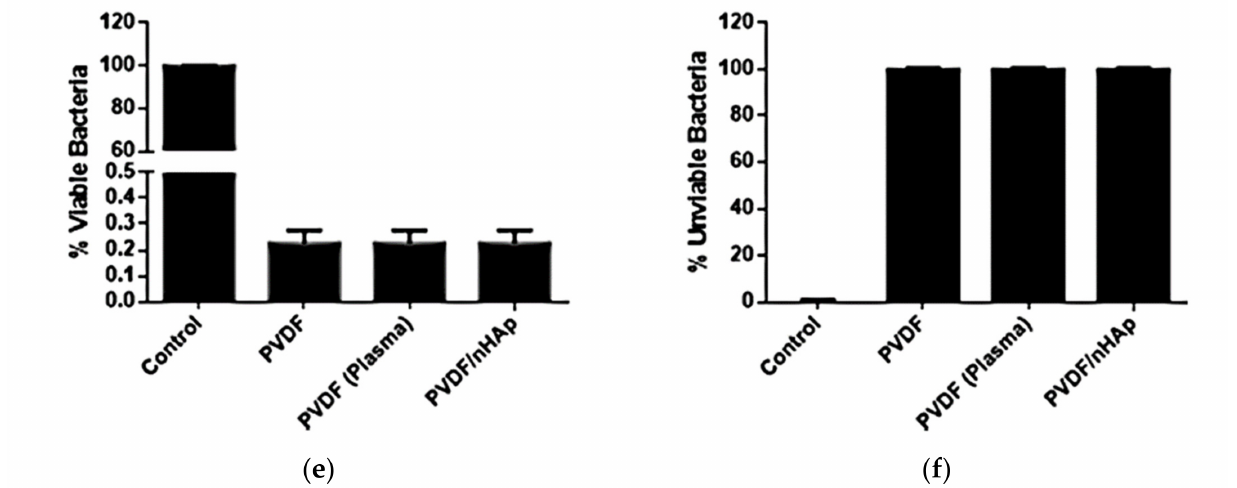
Figure 6. nHAp electrodeposition onto electrospun PVDF nanofibers illustrated in ( a ) SEM micrographs and confirmed by ( b ) the chemical composition obtained from the EDS spectra (Ca/P ratio = 1.64), and by typical bands and peaks attributed to PVDF and nHAp viewed using ( c ) Raman spectroscopy spectra and ( d ) ATR-FTIR spectra. The excellent bactericidal effect of the PVDF/nHAp scaffold is demonstrated in the graphs of proliferation of ( e ) viable bacteria and ( f ) unviable bacteria. Reprinted with permission